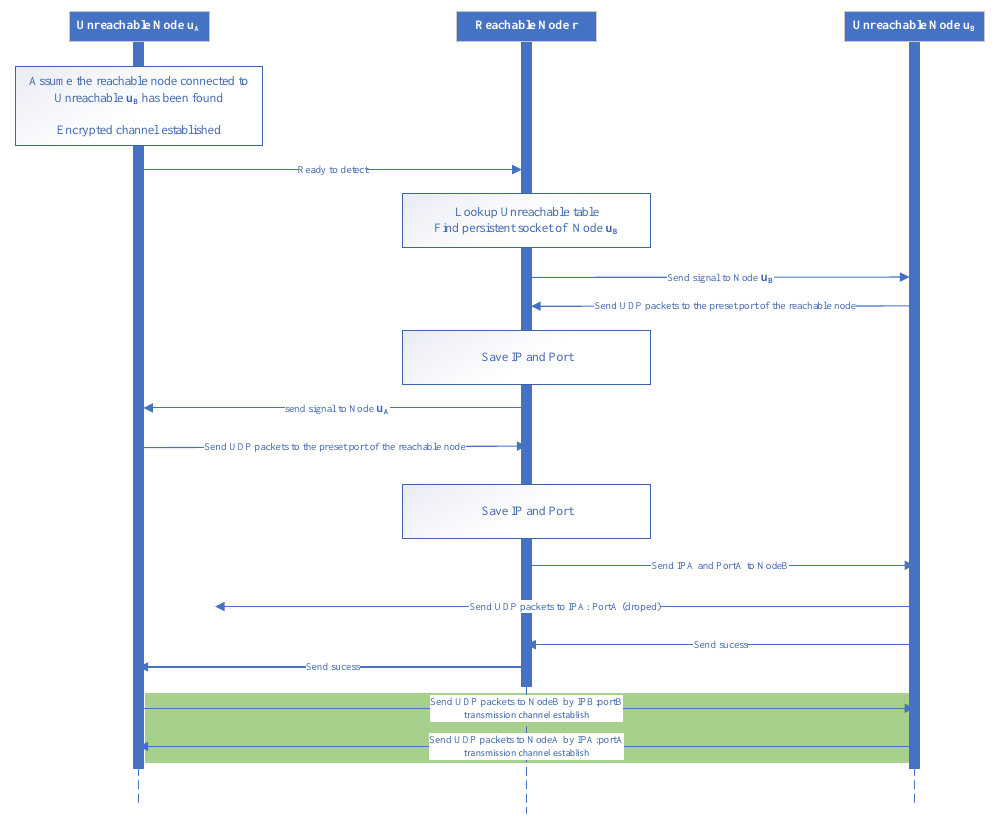
Figure 12. Flowchart of the direct data transmission channel of the unreachable nodes u A and u B